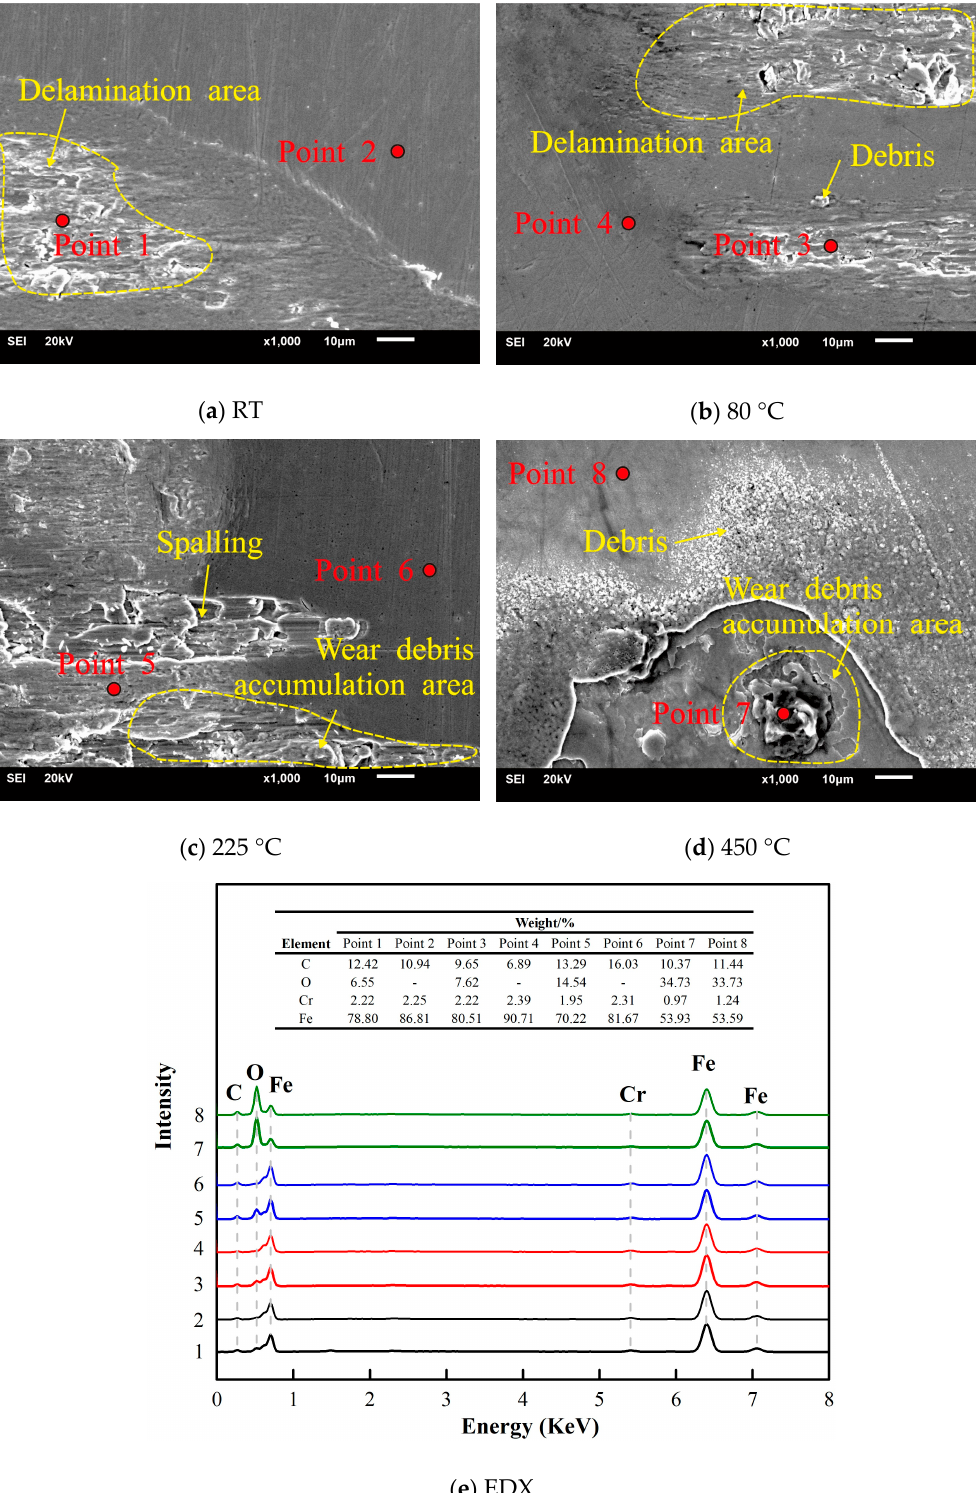
Figure 9. SEM micrographs and EDX of worn scars, D = 50 μ m, F = 20 N.